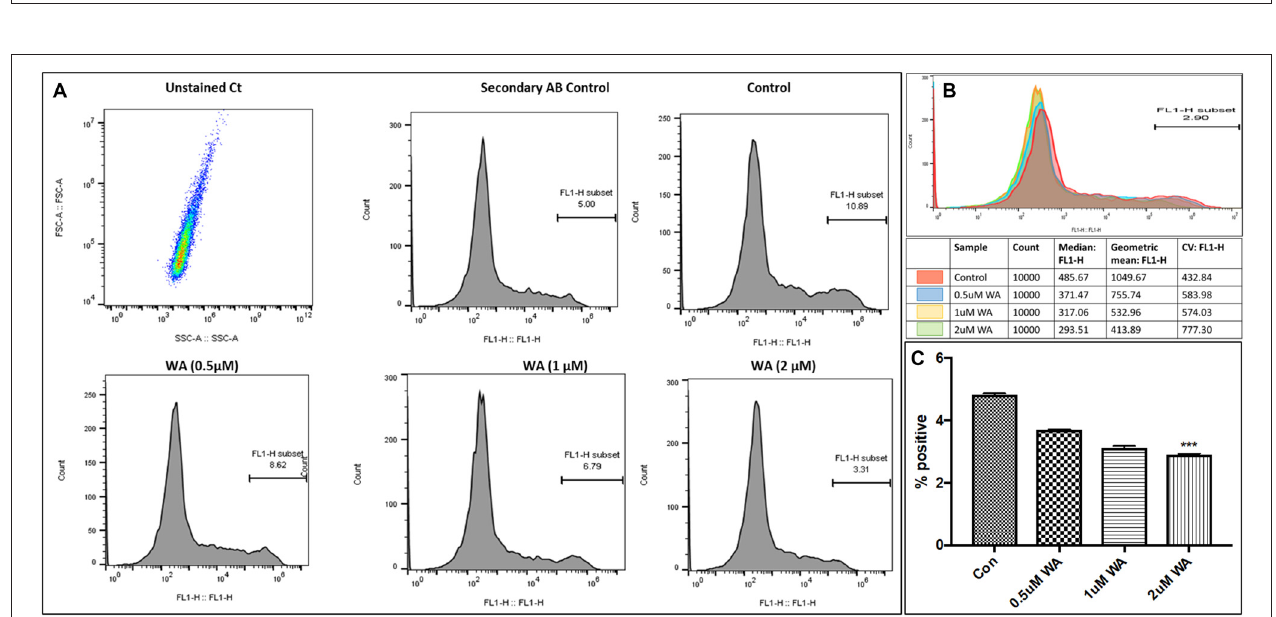
FIGURE 2 | WA inhibits A β 1–40 in concentration dependent manner. Panel (A) shows histograms of A β secretion by the SH-APP cells upon treatment with varying dose of WA. Panel (B) shows the layover of the peaks in one histogram, and (C) shows the quantification of the same. The cells were treated with WA concentrations, and after 48 h of treatment were analyzed by Flow cytometry for determining A β 1–40 levels. Flow cytometry was used to identify the expression of A β 1–40 in SH-APP cells after treatment with three different concentration of WA. 1 × 106 SH-APP cells were stained with primary anti-human A β 40 (#PA3–16760) and secondary anti-rabbit Fluorescein isothiocyanate (FITC)-labeled antibody (catalog #AP187F, Millipore). Auto fluorescence of the cells was based on the unstained cells. Cells were gated based on the secondary antibody. Accuri BD flow and Amnis (cid:114) Imaging Flow Cytometers were used for acquisition. Analysis was conducted in Flow Jo software and Amnis (cid:114) FlowSight (cid:114) Imaging Flow Cytometer and analysis by IDEAS (cid:114) Image software. For each experiment, from all events collected, FITC positive cells were gated from single cells ( ∗∗∗ p ≤ 0.001).